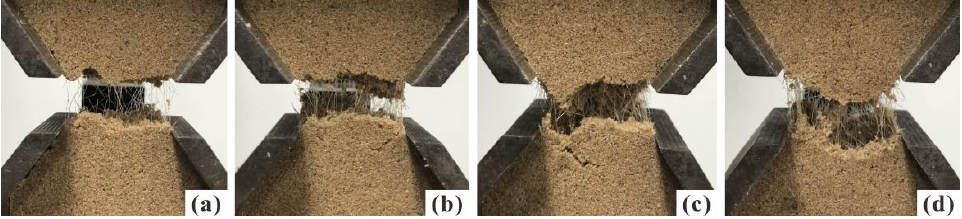
Figure 8. Photographs of specimen with different PF content after test: ( a ) f = 0.2%; ( b ) f = 0.4%; ( c ) f = 0.6%; ( d ) f = 0.8% ( p = 2%, 𝜌 𝑑 = 1.50 g/cm 3 and t = 48 h).